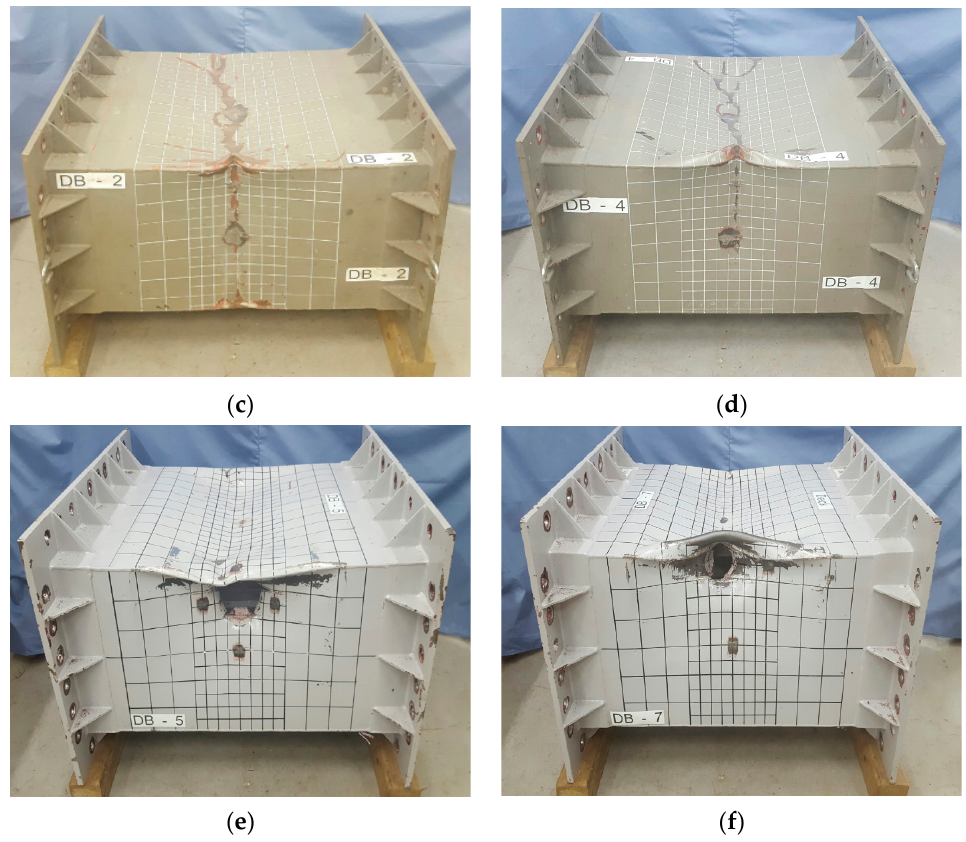
Figure 13. Collapsed shapes of the models: ( a ) IB-1; ( b ) IB-2; ( c ) DB-2; ( d ) DB-4; ( e ) DB-5; ( f ) DB-7.